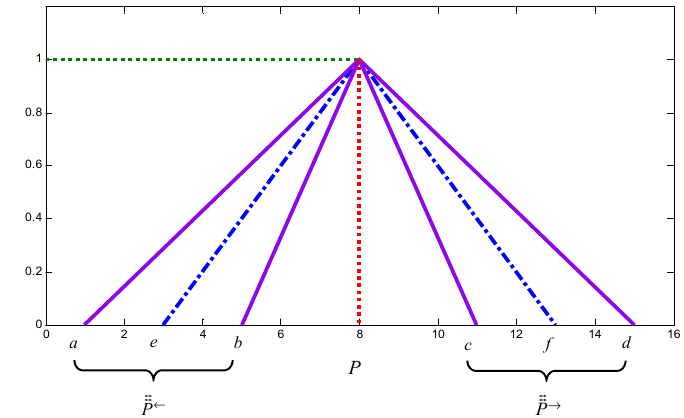
Figure 2. T2FDP around eight.